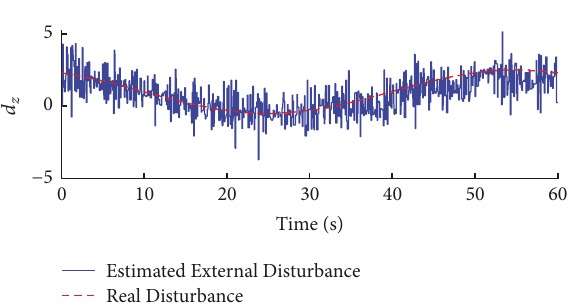
Figure 5: Disturbance estimation in function of time for the NLLS- 2L